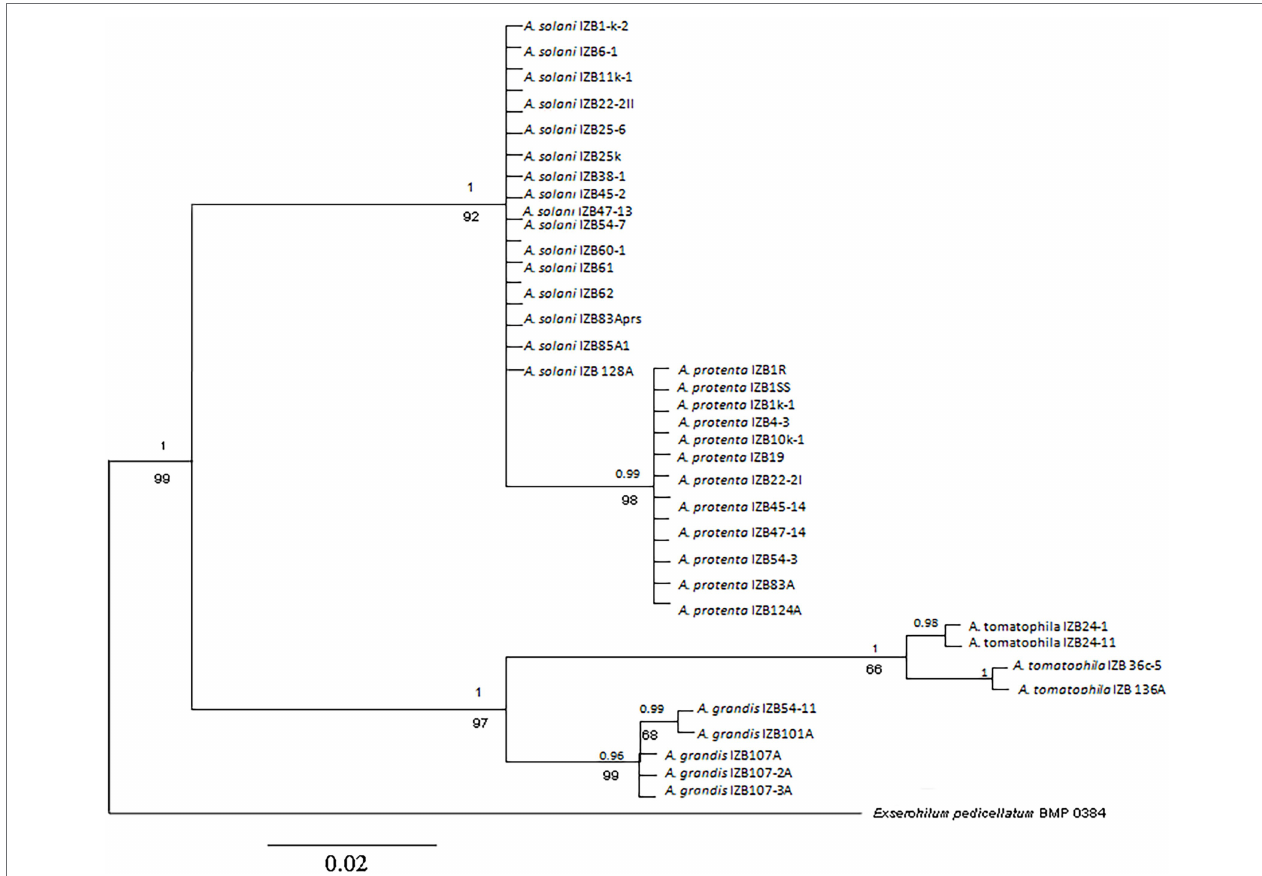
FIGURE 3 | Phylogenetic tree based on Bayesian analysis of the concatenated sequences of the GAPDH, Rpb2, and calmodulin genes of Alternaria strains from potato. Bayesian posterior probabilities are shown above branches, and maximum likelihood bootstrap support values are indicated below branches. Bar: the estimated nucleotide substitutions per site are 0.02. The numbers near each branch represent percentages out of 1,000 bootstrap